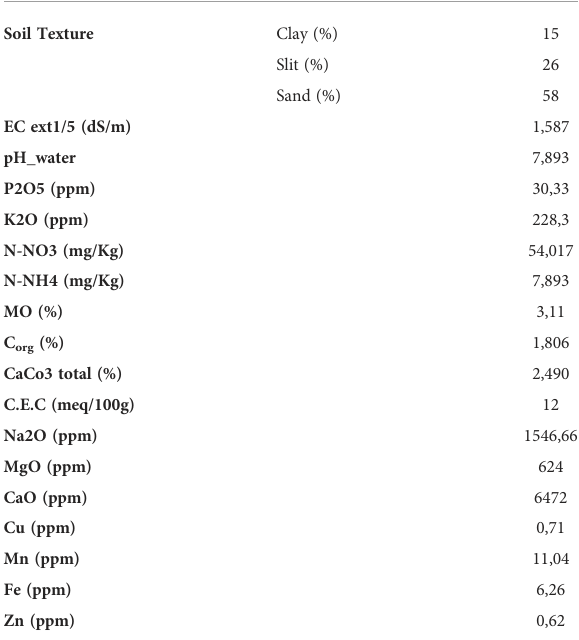
TABLE 1 Physicochemical properties of the experimental soil. Soil